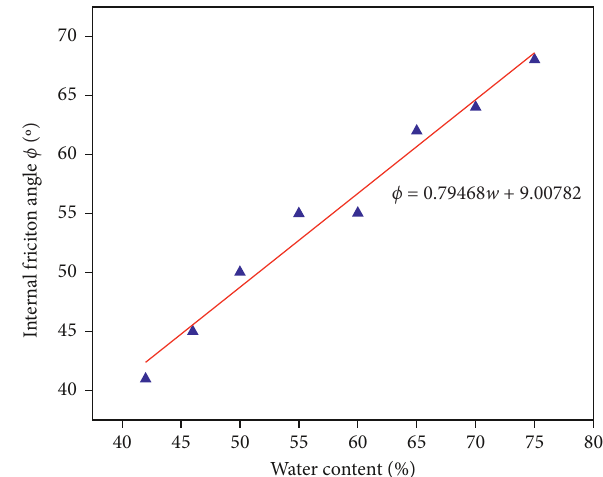
Figure 8: Relationship between water content and internal friction angle caused by rainfall on